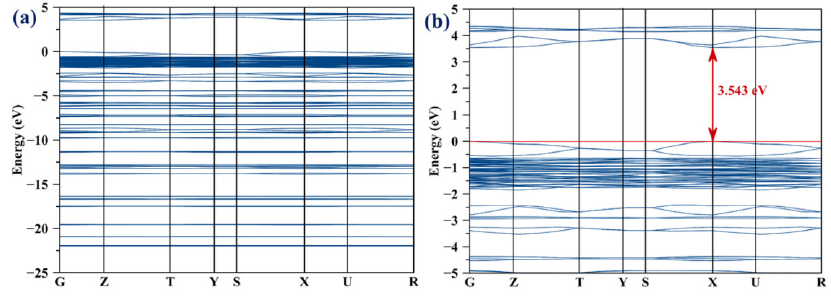
Figure 9. Electronic band structure of (C 2 H 7 N 4 O) 2 BiCl 5 : ( a ) overall view, ( b ) enlarged view.